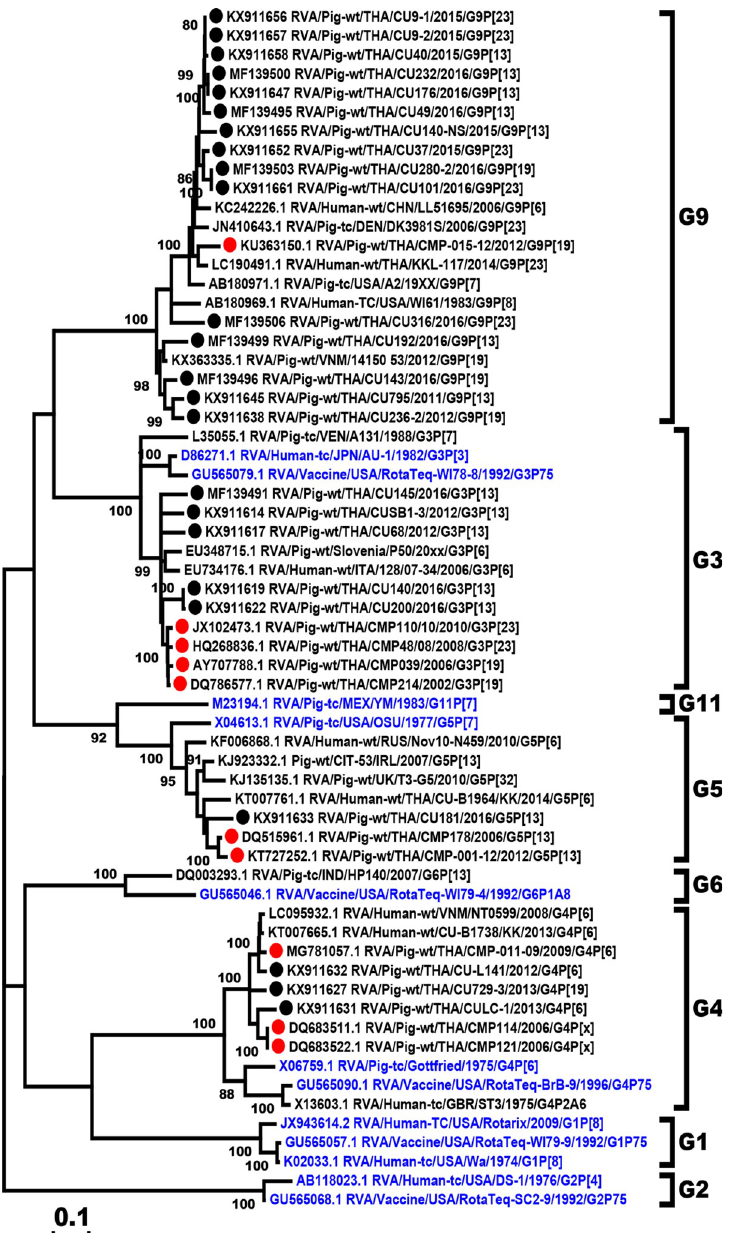
Fig 1. Phylogenetic analysis of the RVA VP7 gene. The nucleotide sequences of the Thai strains (black dotted) were compared to those of previous Thai porcine RVA strains (red dotted), the RVA reference and vaccine strains (blue).